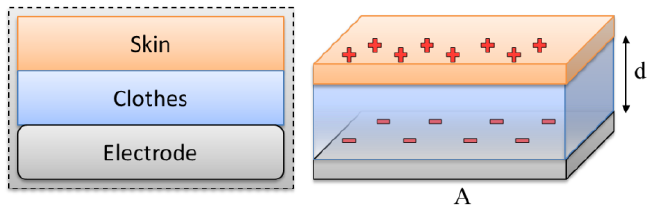
Figure 2. Body–electrode interface that forms the coupling